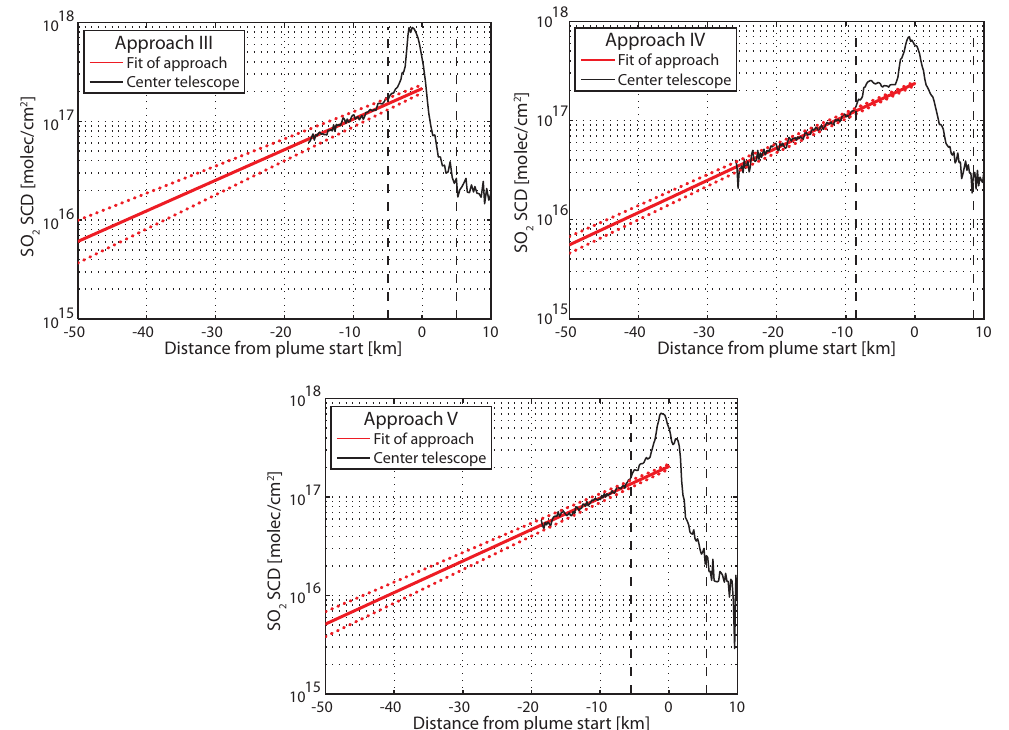
Fig. 11. Approaches III–V extrapolated to 50km distance. Fitted function is depicted as red line with 95% confidence bands as red dots. Measurement regime C is indicated by dashed vertical lines.